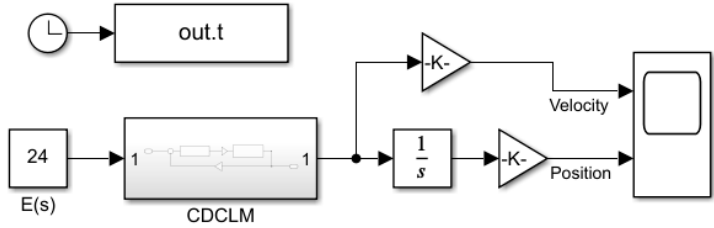
Figure 14. Static force versus position graphic.